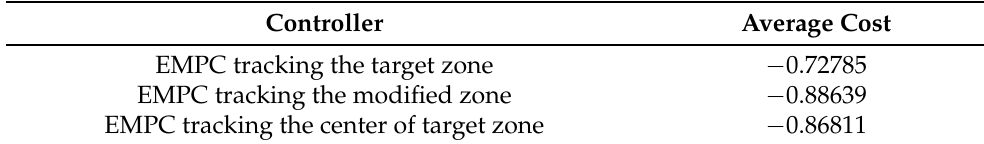
Table 5. Comparison of the nominal EMPC with target zone tracking and the two EMPCs with modified zone tracking (smaller is better).